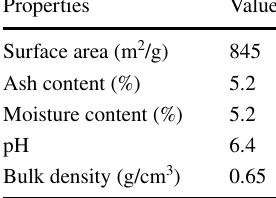
Table 2 Surface